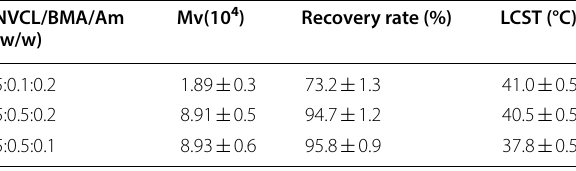
Table 1 Recovery rate and LCST of polymers prepared